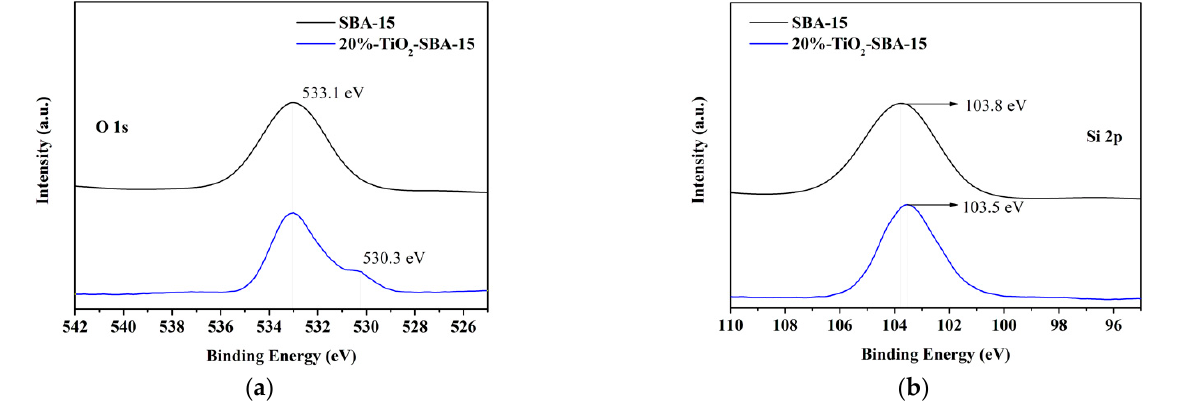
Figure 5. ( a ) O 1s XPS spectra of SBA-15 and 20%-TiO 2 -SBA-15, ( b ) Si 2p XPS spectra of SBA-15 and 20%-TiO 2 -SBA-15.